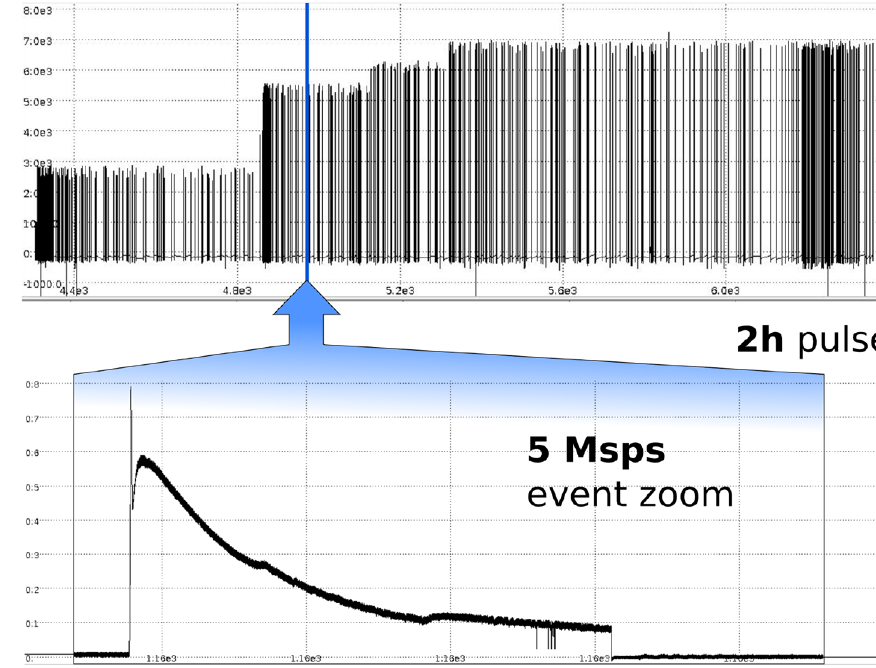
Figure 25. Current measurement on the extraction grid of NIO experiment, with self triggered high- resolution capture of breakdown